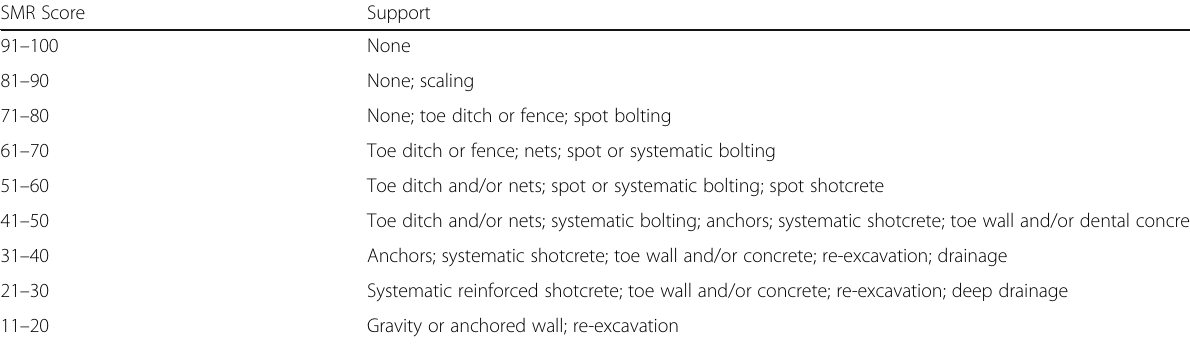
Table 17 Recommended support according to SMR score (Romana